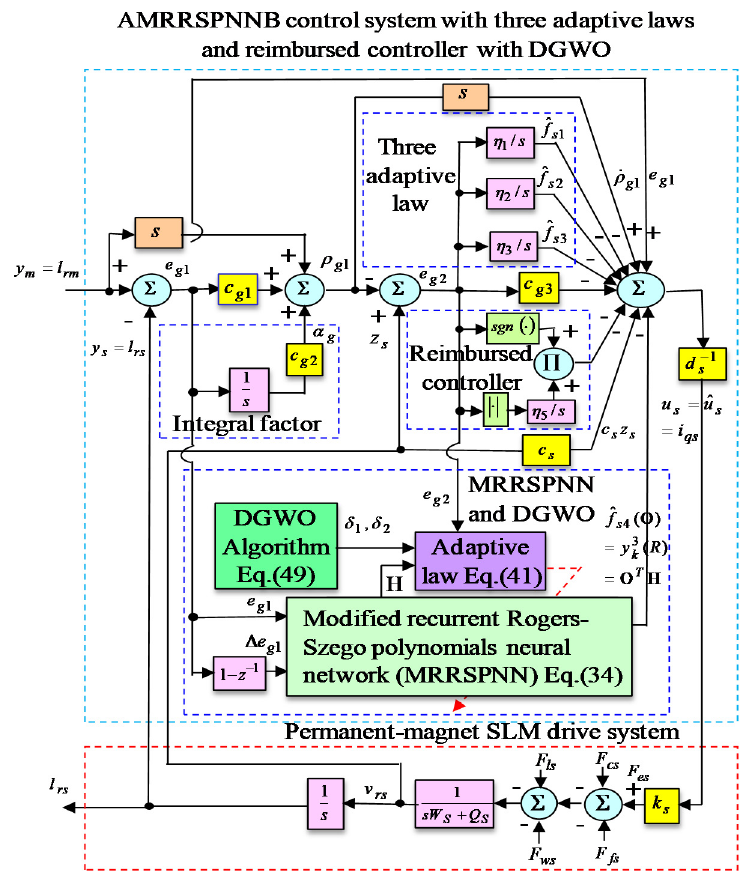
Figure 5. Block diagram of the AMRRSPNNB control system with three adaptive laws and reimbursed controller with DGWO.